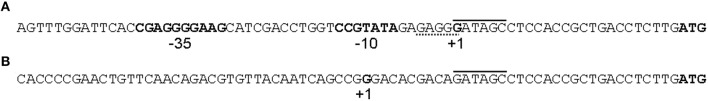
(A) Sequence of the intergenic region between cnrH and cnrC with the last three nucleotides (ATG) being the start codon of cnrC. The −35 and −10 box and transcription start of cnrC are highlighted in bold. Integration sites of ISRme5 (full line) and IS1086 (dashed line) are indicated above and below the sequence, respectively. (B) Sequence of the newly formed cnrC promoter via ISRme5 insertion with direct repeat at the point of insertion (full line) and transcription start.